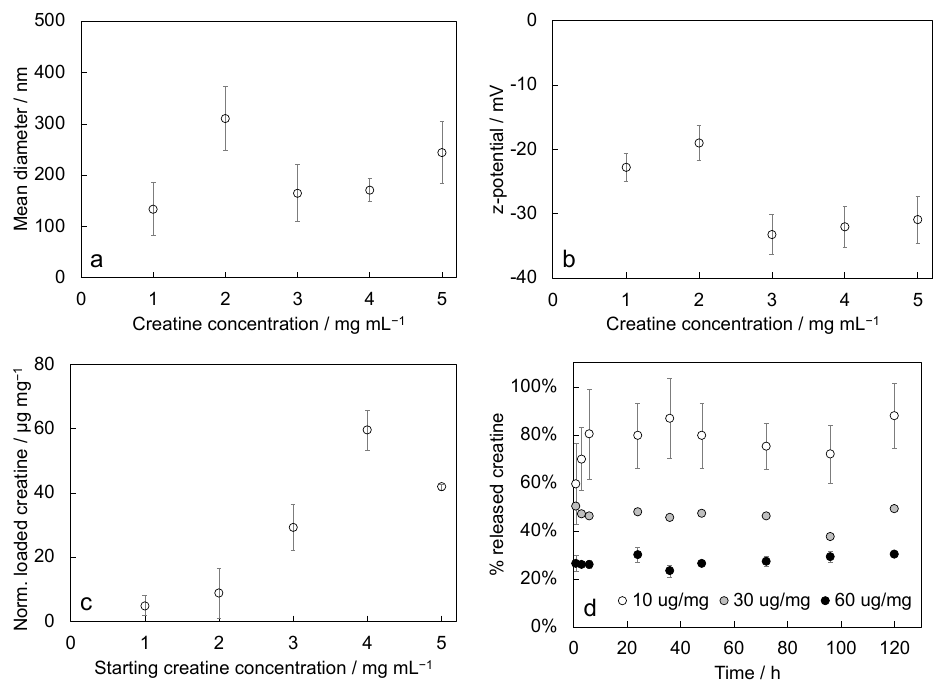
Figure 5. Characterization of creatine-loaded stabilized reversed micelles: ( a ) mean diameter and ( b ) z-potential of micelles loaded with different starting amounts of creatine; ( c ) amount of loaded creatine ( μ g) by varying the starting creatine solution concentrations, normalized to the actual amounts of micelles (mg); ( d ) percent of released creatine through time ( μ g) with respect to the actual amounts loaded, in the legend formulations are labeled according to the amount of creatine loaded per mg of RMs. In plots ( a – c ), the x -axis reports the starting concentration of the creatine solution used during the loading procedure.